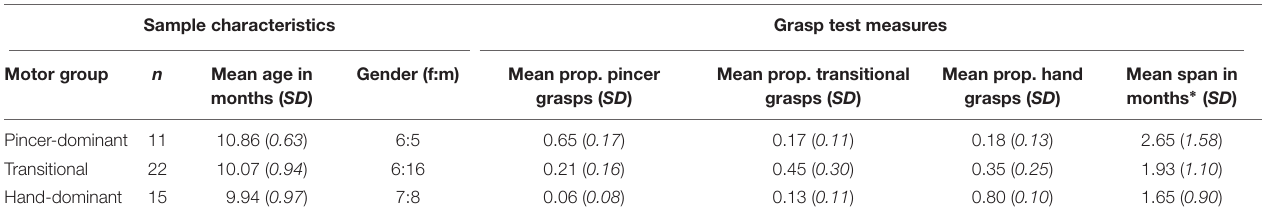
TABLE 1 | Characteristics of the final